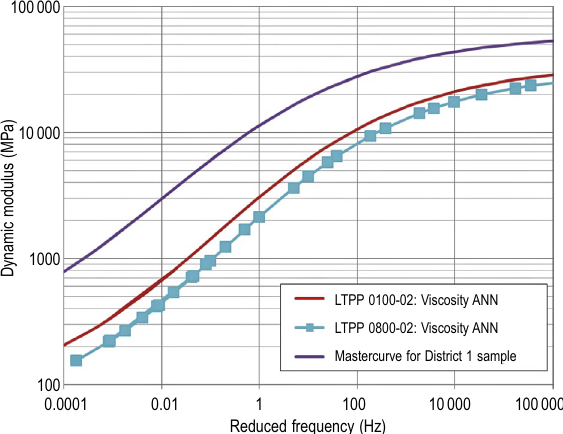
(Hz)0.0001 Reduced frequency Fig. 3. Dynamic modulus mastercurves from laboratory tests and LTPP viscosity base ANN model for New Mexico District 1